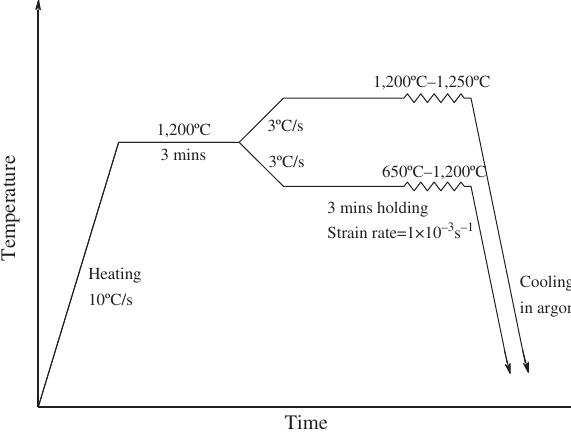
Figure 1: Schematic diagram for processing of the tensile